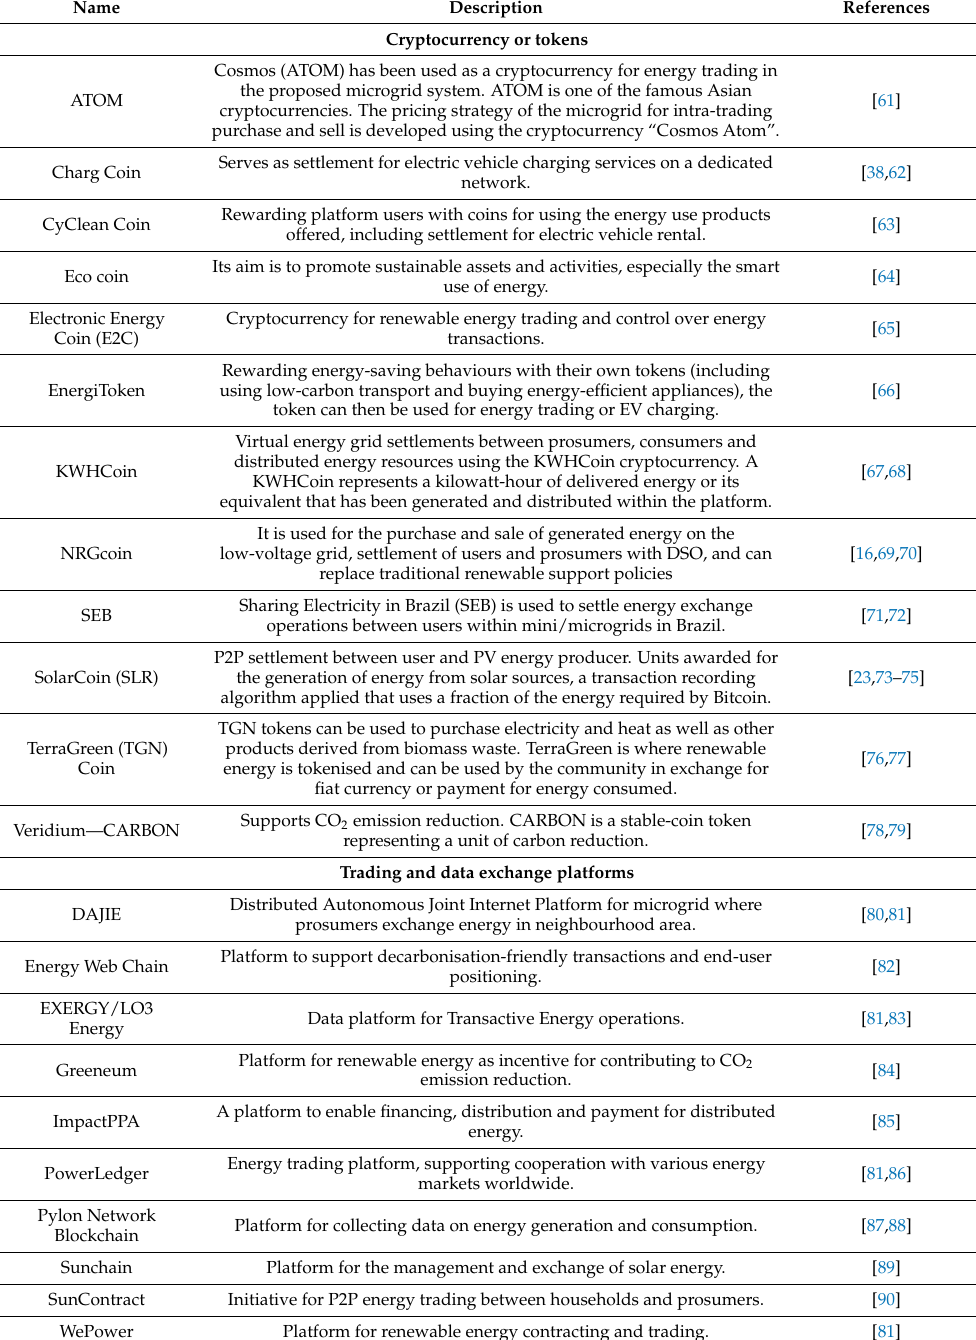
Table 2. Examples of published and implemented energy settlement concepts using tokens in DLT, also interpreted as offers of special